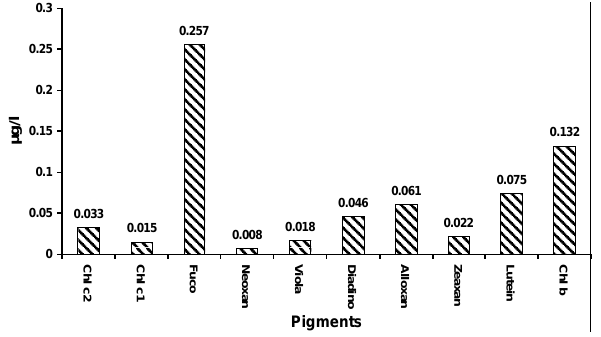
Fig. 6. Mean pigment concentrations, chlorophyll a not included